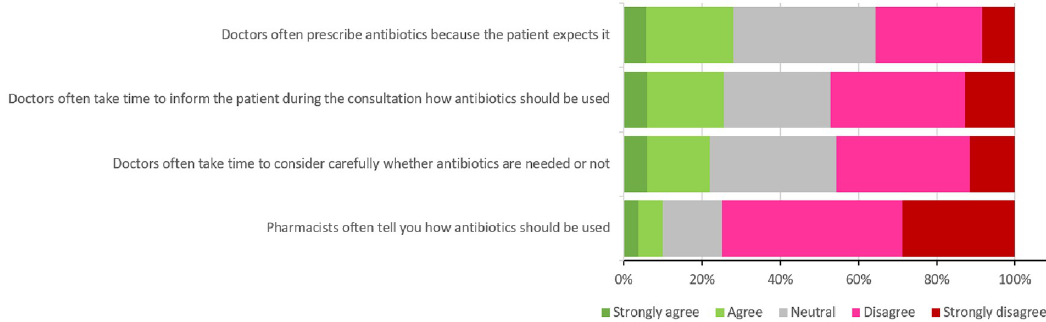
Fig 4. Respondents’ opinions on healthcare providers’ antibiotic prescription